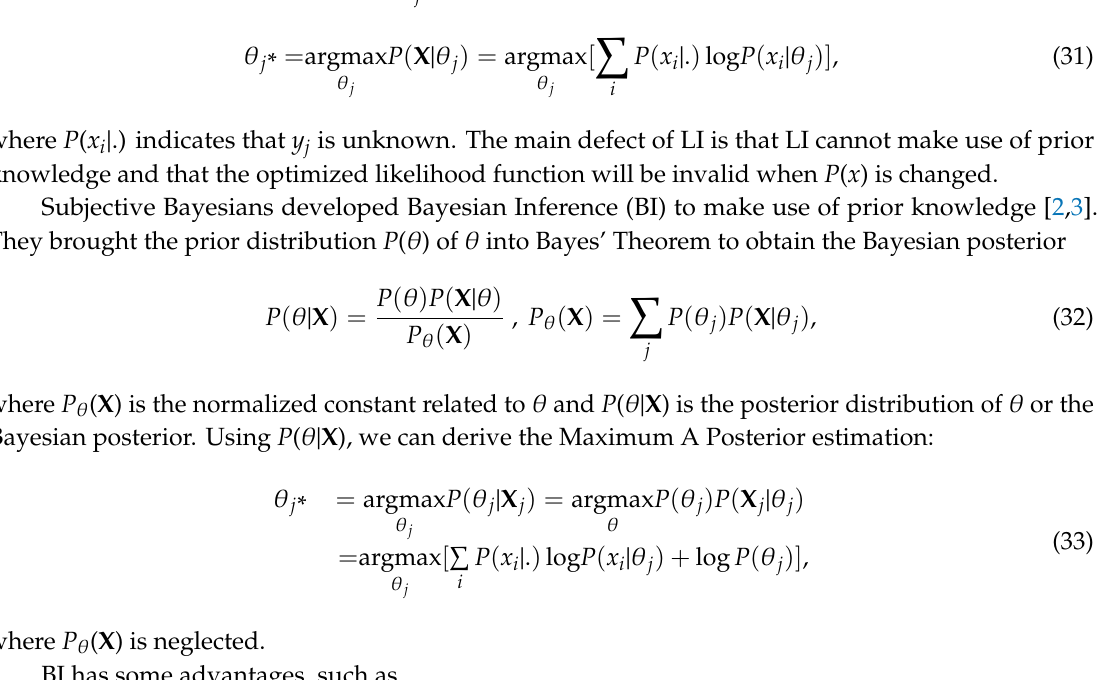
* Data are obtained from OREQuick HIV tests